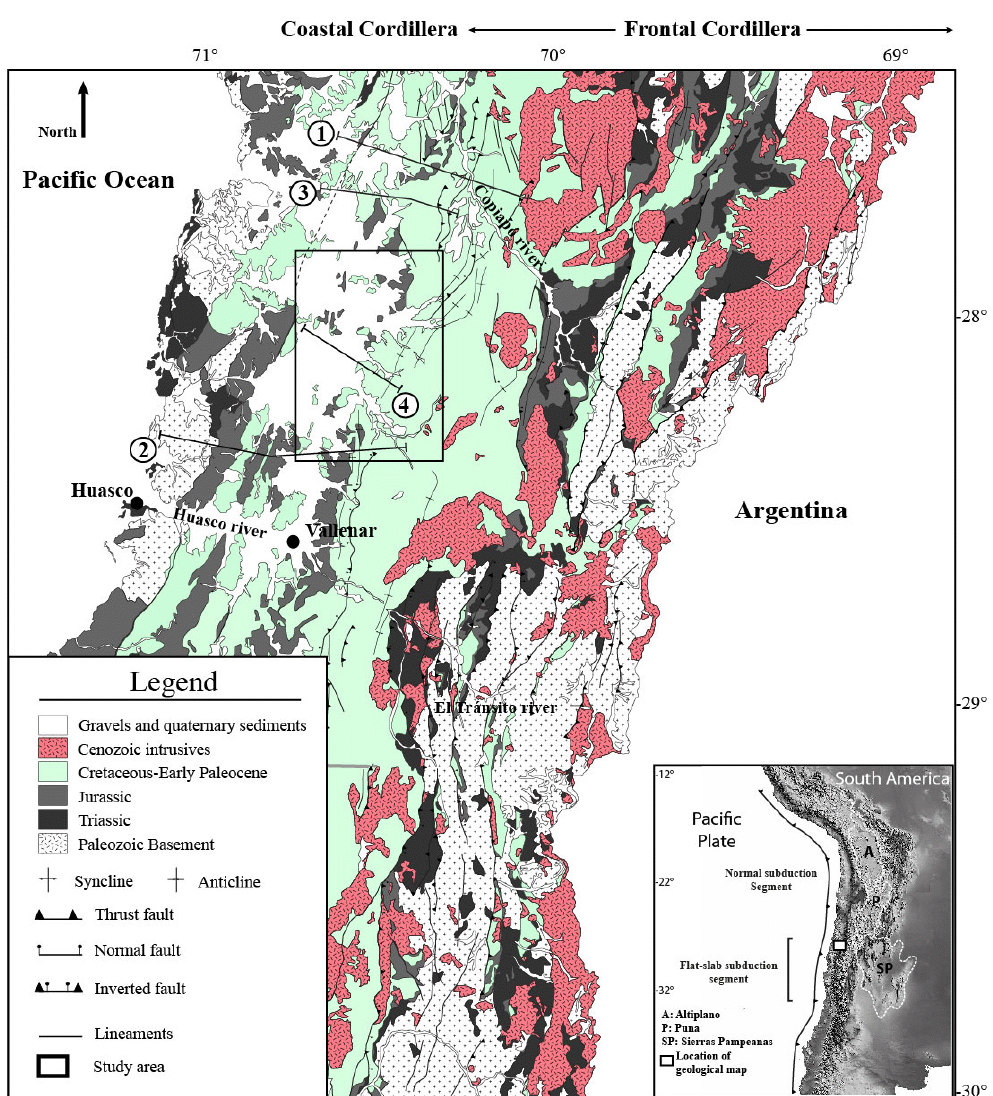
Figure 1. Simplified geological map of northern Chile (27 ◦ 30 (cid:48) –30 ◦ 00 (cid:48) S), showing the distribution of the main tectonic provinces (Coastal Cordillera and Frontal Cordillera), stratigraphic units, regional structures and the location of the study area (modified from Sernageomin, 2003, Scale: 1 : 1 .